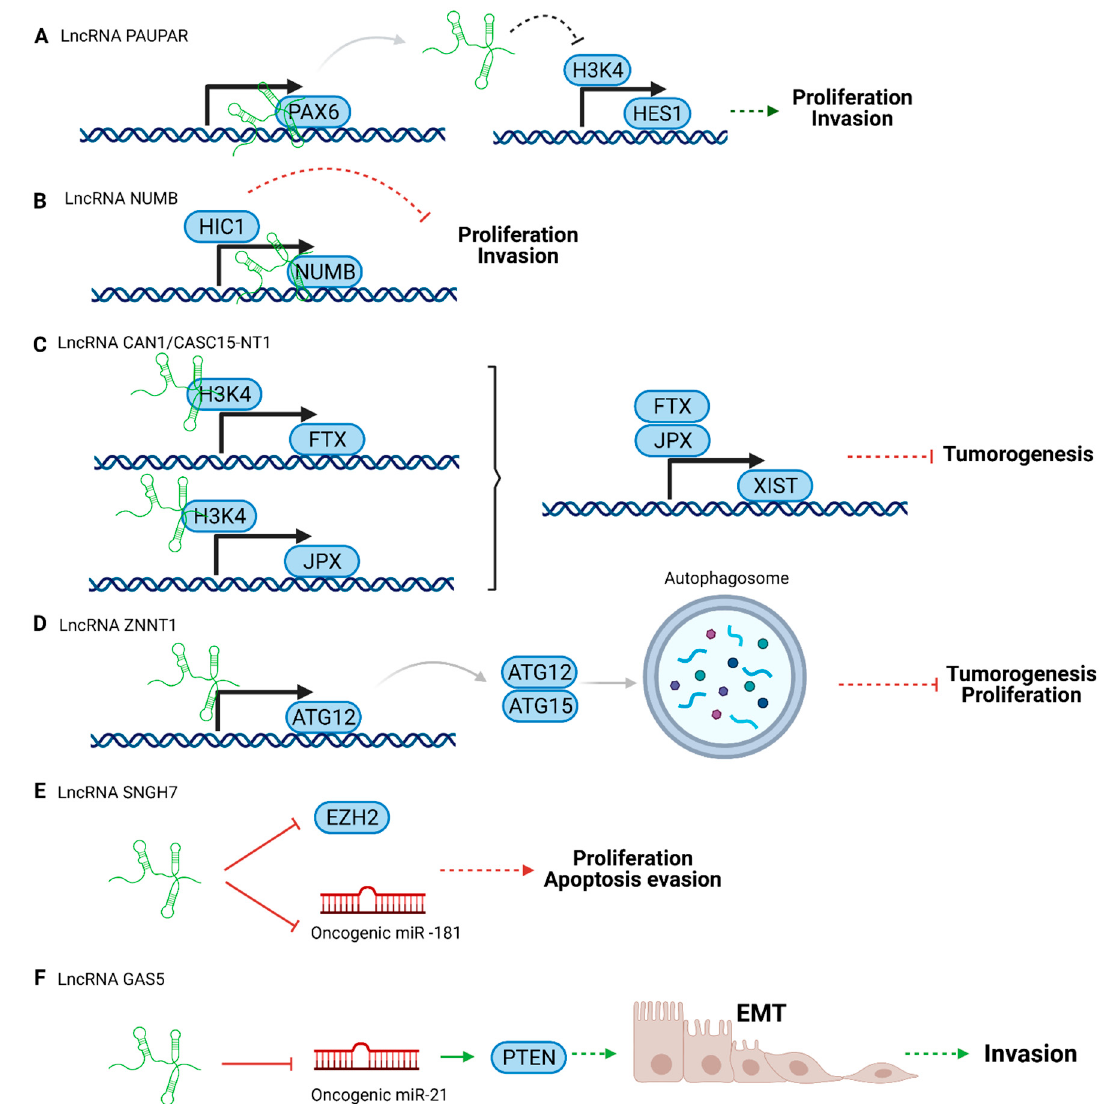
Figure 2. Scheme of tumor suppressor lncRNA pathways in uveal melanoma. ( A ) lncRNA PAUPAR, ( B ) lncRNA NUMB, ( C ) lncRNA CAN1/CASC15-NT1, ( D ) lncRNA ZNNT1, ( E ) lncRNA SNGH7, and ( F ) LncRNA GAS5. Created with BioRender.com, accessed on 26 October